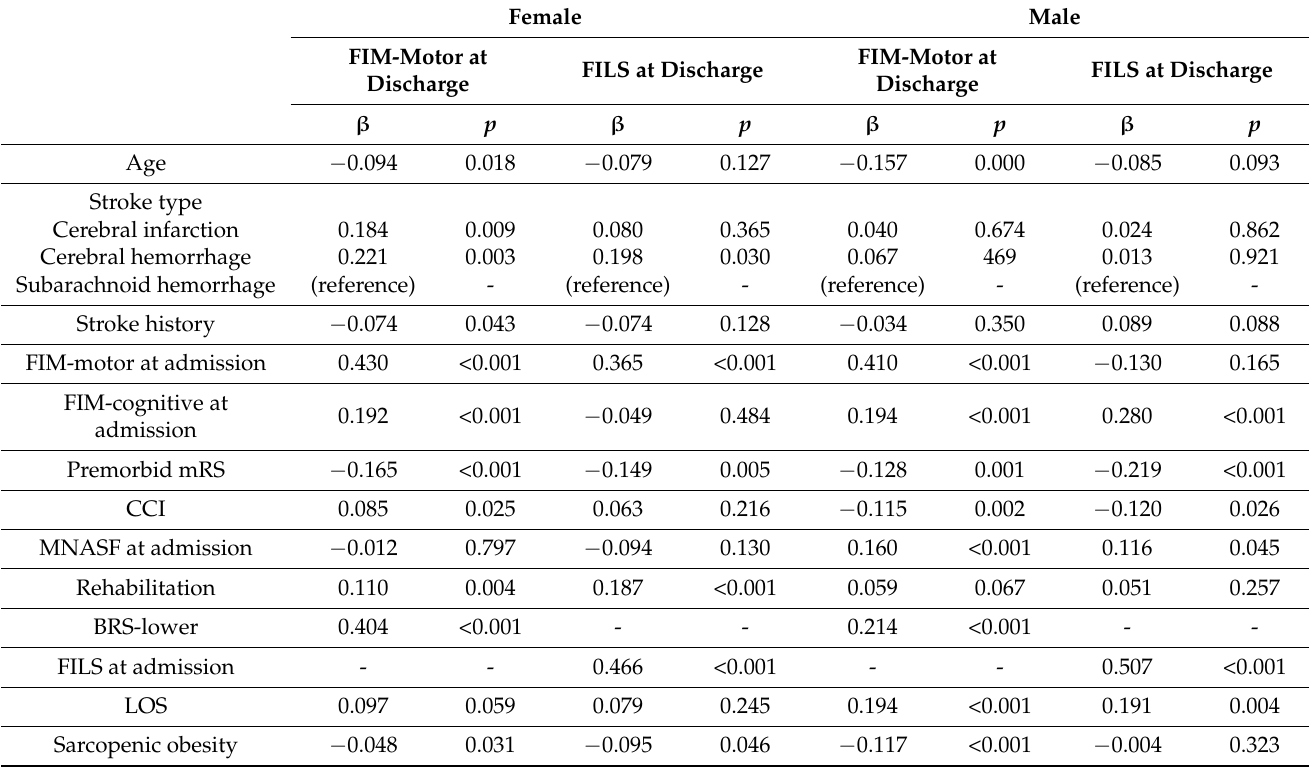
Table 4. Multivariate analyses of sarcopenic obesity defined by ESPEN and EASO criteria 2022